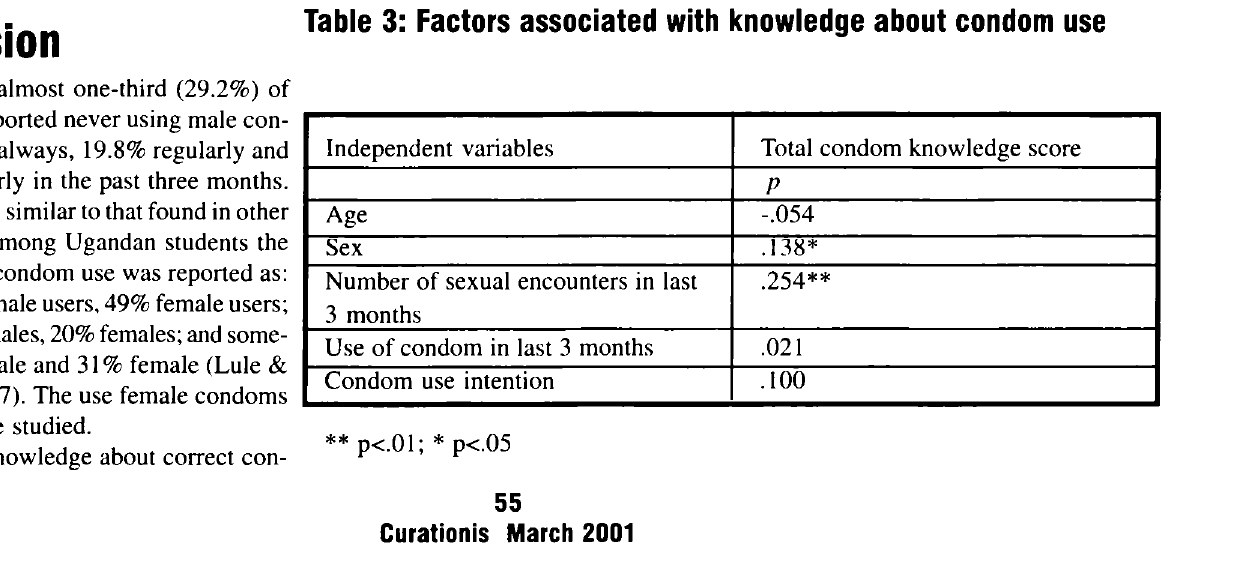
Table 3: Factors associated with knowledge about condom